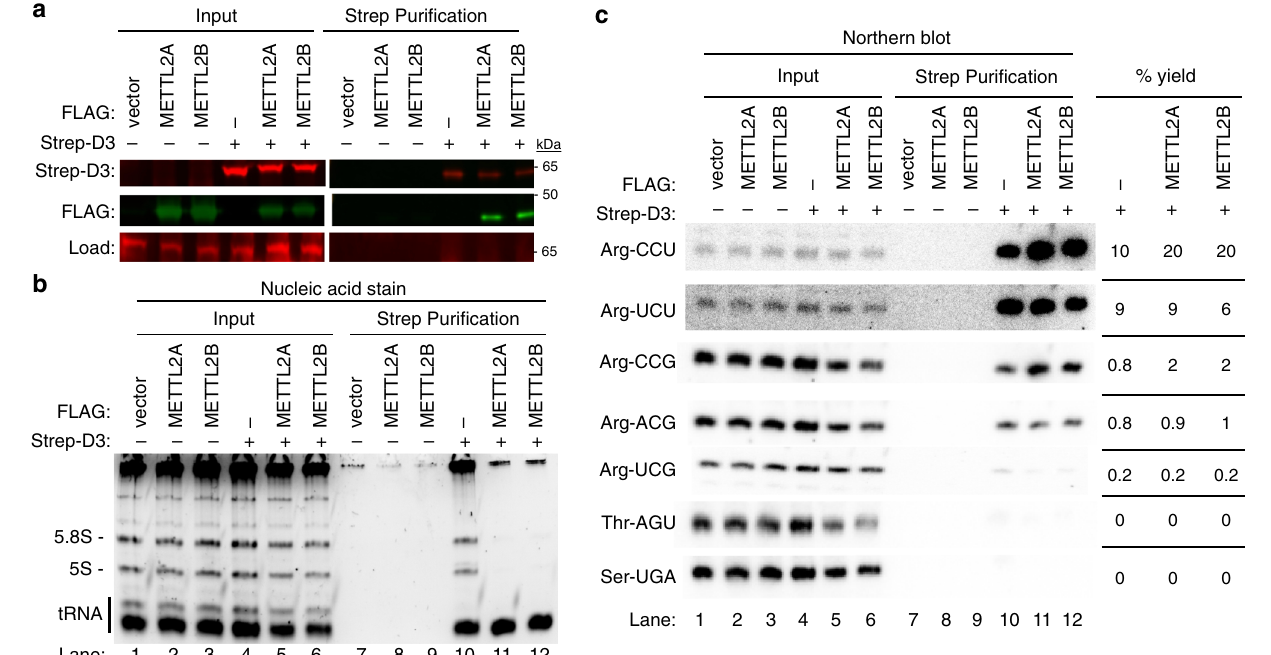
Fig. 2 DALRD3 forms a complex with METTL2A/B to bind distinct arginine tRNAs. a Immunoblot of Strep-DALRD3 puri fi ed from 293T cells expressed alone or in conjunction with FLAG-METTL2A/B. Immunoblot was probed with anti-TwinStrep and anti-FLAG antibodies. Load represents a non-speci fi c protein band detected by the anti-Strep antibody used as load control. b Nucleic acid stain of RNAs extracted from the indicated input or puri fi ed samples after denaturing PAGE. The migration pattern of 5.8S rRNA (~150 nt), 5S rRNA (~120 nt) and tRNAs (~70 – 80 nt) are denoted. c Northern blot analysis of the gel in b using the indicated probes. Input represents 2% of total extracts used for puri fi cation. The percentage yield represents the amount of RNA in the Strep puri fi cation that was recovered from the total input. The experiment was performed three times with comparable results. Quanti fi cation was performed on the blot shown. Source data are provided as a Source data fi